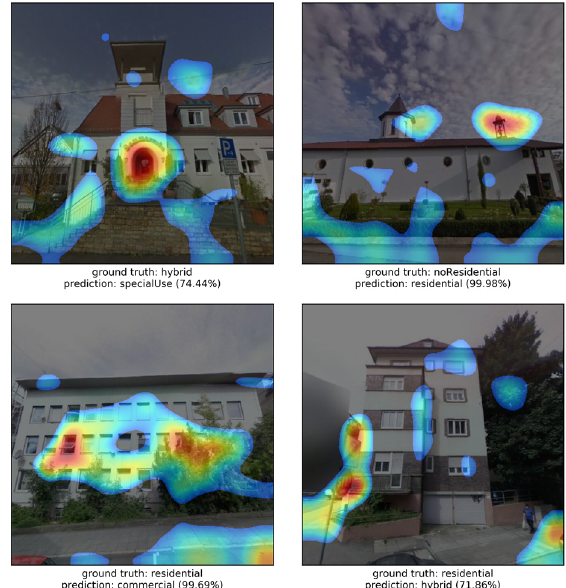
Figure 6. Mispredicted images overlaid by corresponding upsampled CAMs for multiclass classification and binary classification ( upper right ).